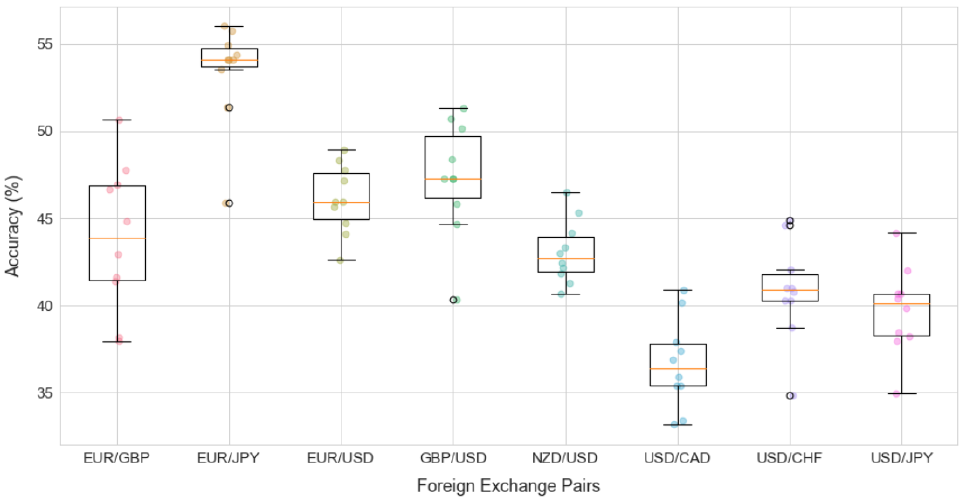
Figure 7. The MRM Model Prediction Accuracy for each of the Foreign Exchange Pairs .